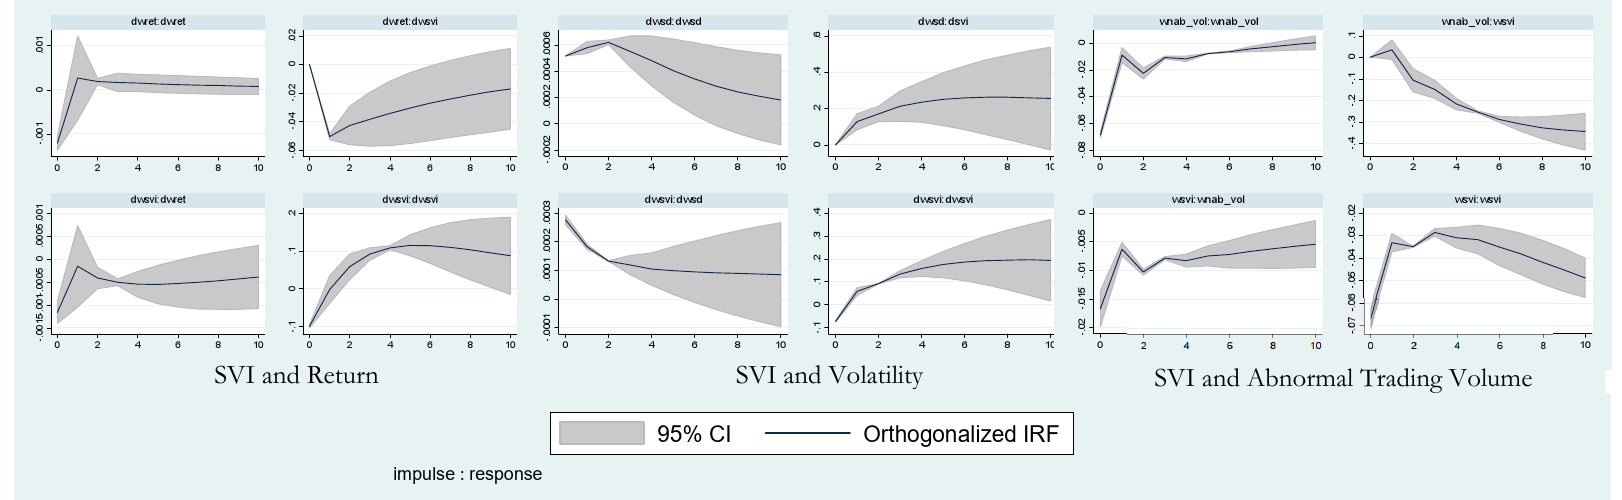
Figure 2. Orthogonalized impulse response for the difference between developed and developing markets. Figure 2 depicts the impulse response function of the difference between the developed and developing markets in three relationships .